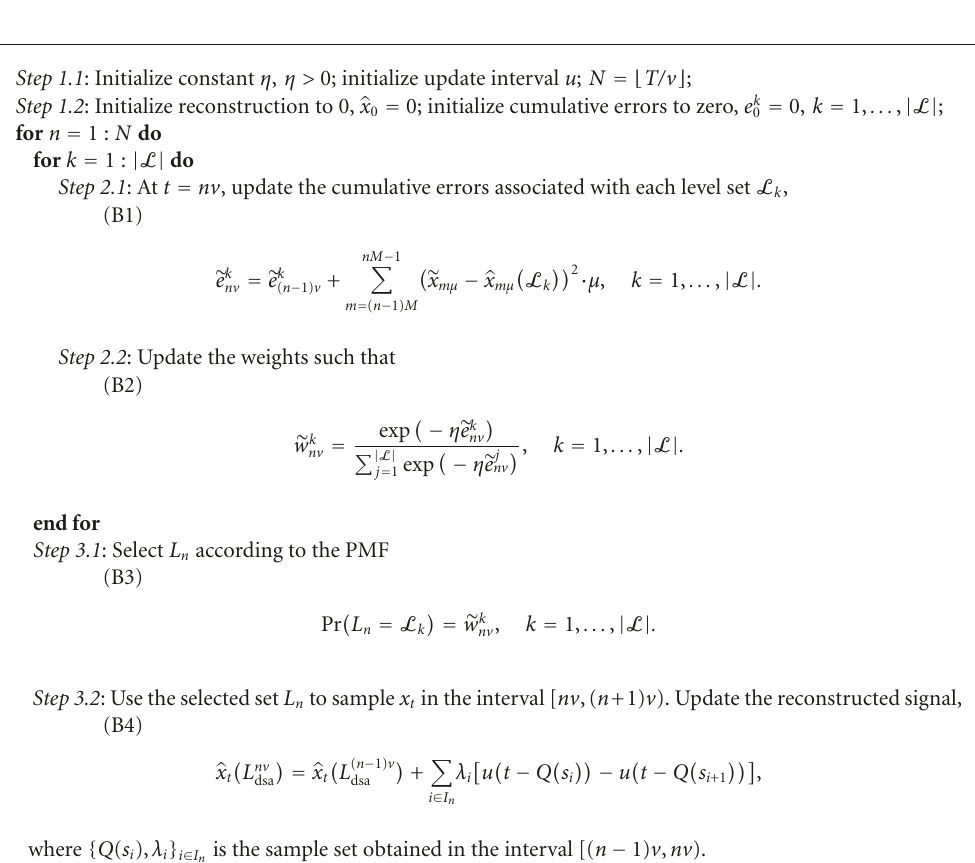
Algorithm 2: Discrete-time sequential algorithm